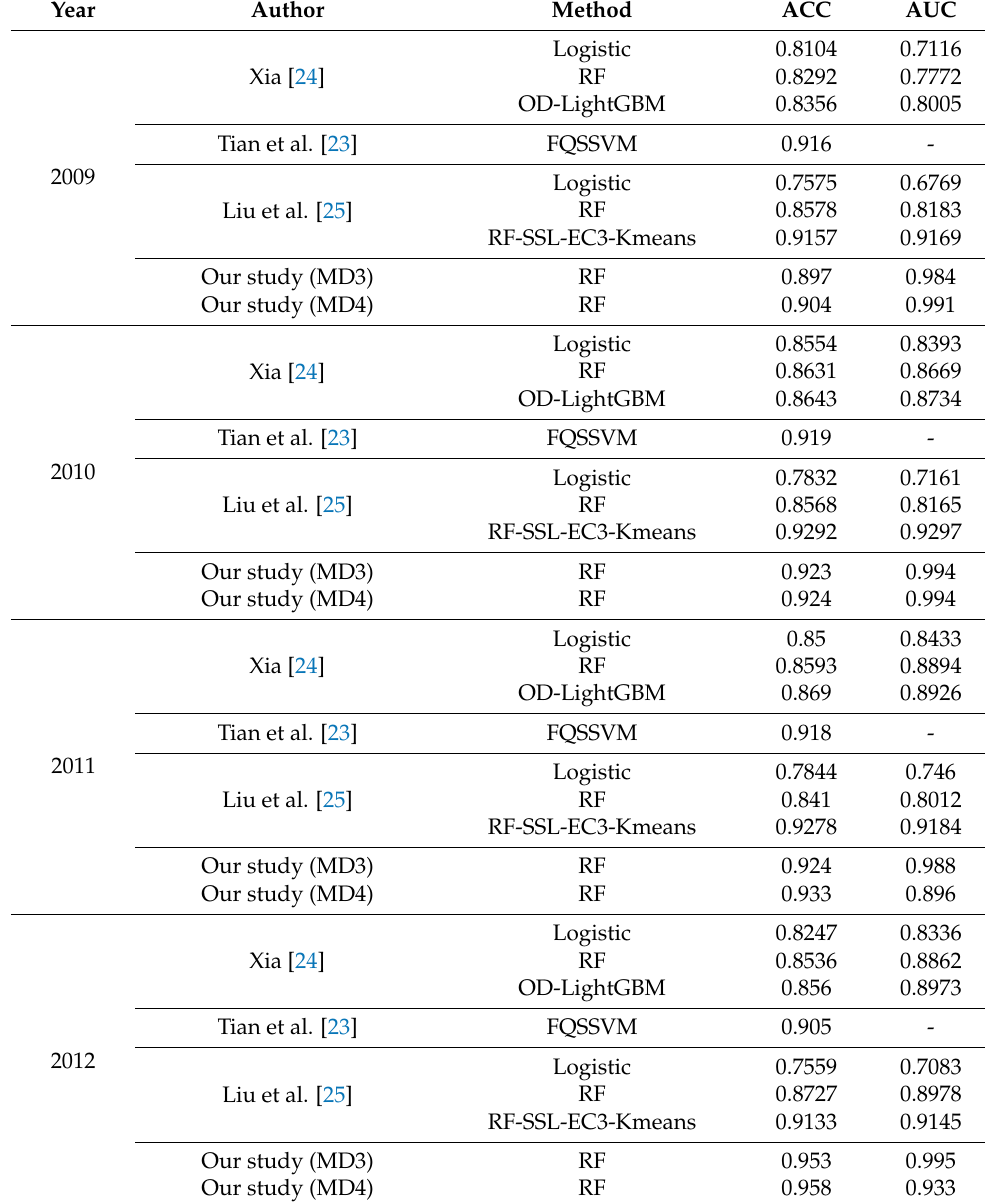
Table 9. The comparison of the results of this study with previous